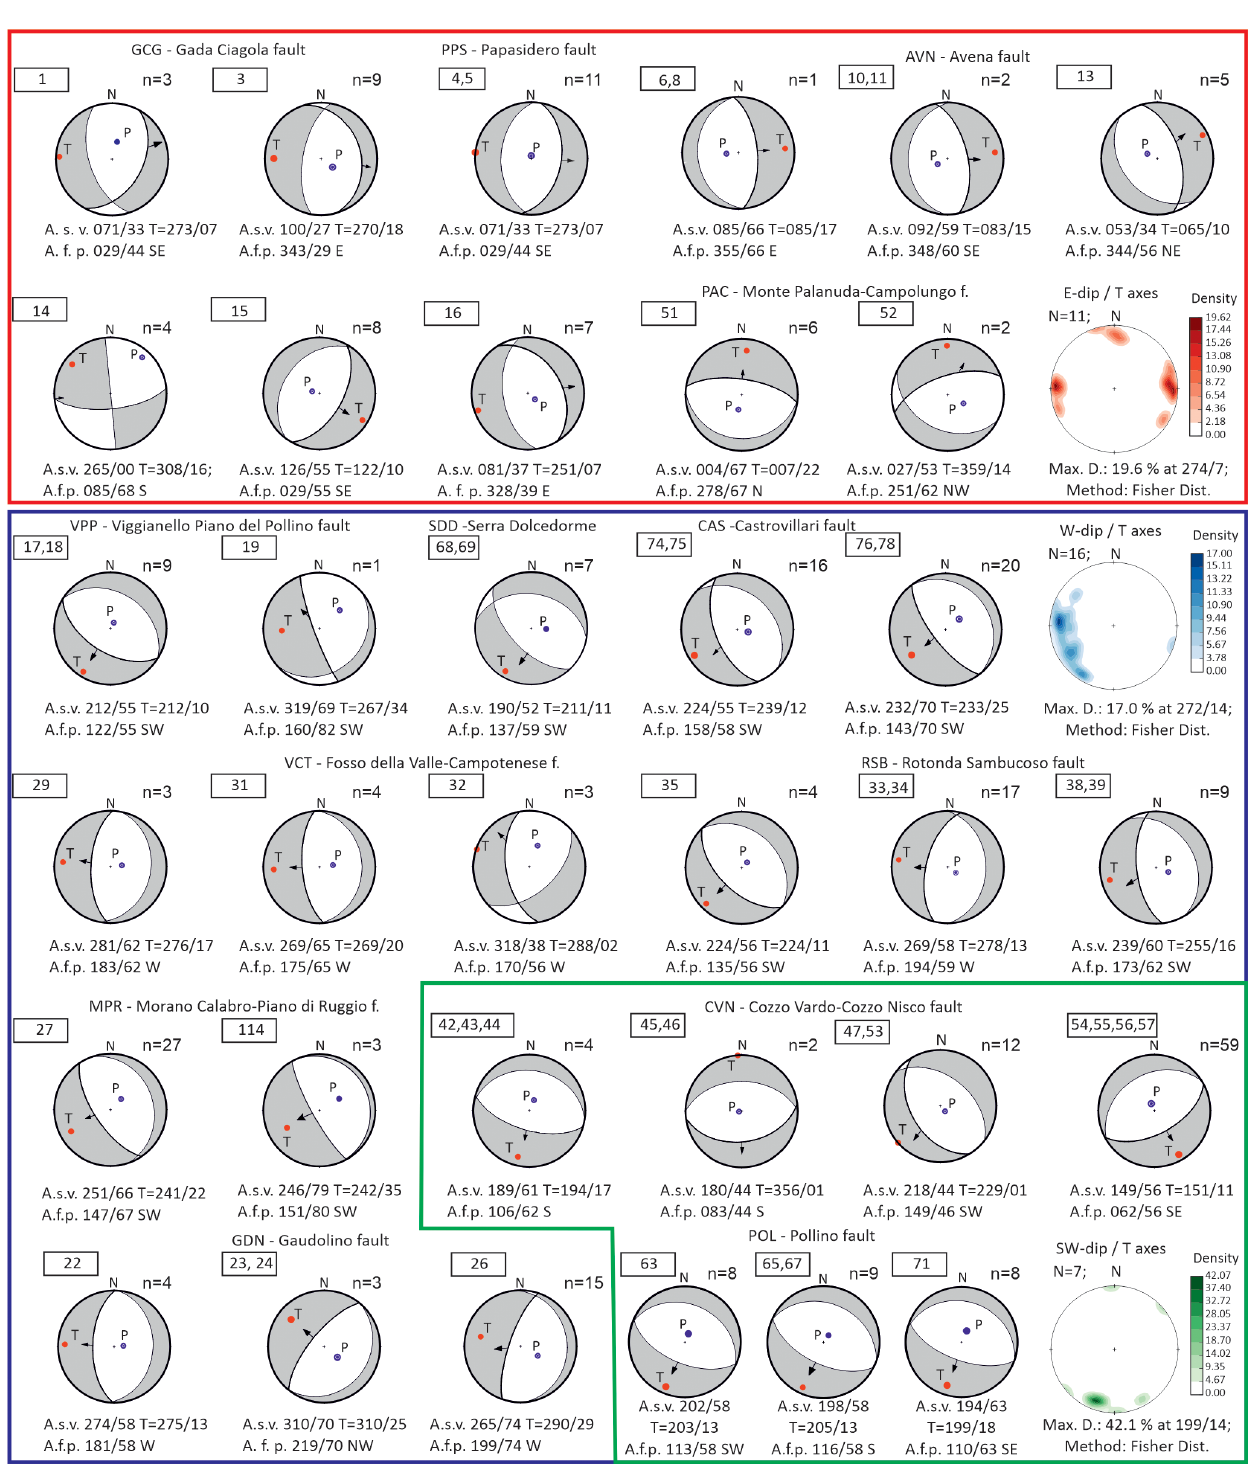
Figure 3. Kinematic analysis and pseudo-focal mechanisms obtained from fault-slip data using the FaultKin 8 software (Allmendinger et al., 2012). Pseudo-focal mechanisms are boxed with different colors on the basis of the fault system to which they belong to (color key as in the map of Figs. 1, 2). For each fault system, the density contour of the T axis computed for each focal mechanism is reported (lower hemisphere projection). A.s.v.: average striae value, A.f.p.: average fault plane, n : number of fault-plane measurements. Numbers in the rectangles (top left of each focal mechanism) refer to the group of fault-slip data belonging to or neighboring a single site (location in Fig. S2).